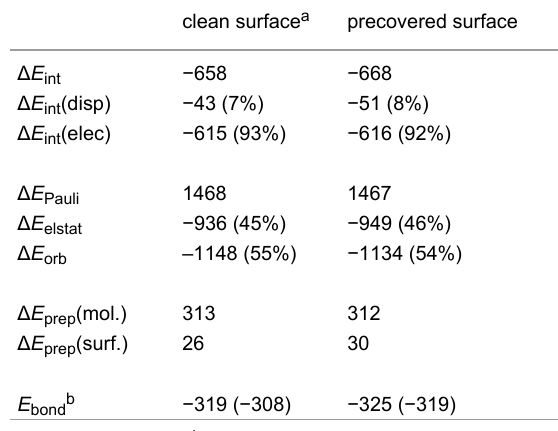
the tilting of the first molecule of 1 , the second adsorbate is not hindered by repulsive interactions. The electronic contribution to the adsorption energy ( E bond (PBE) in Table 2) is indeed un-